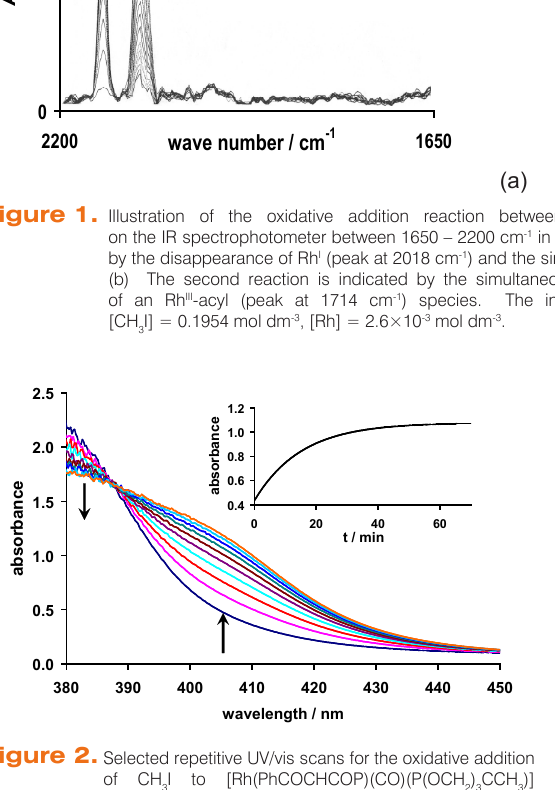
Figure 2. Selected repetitive UV/vis scans for the oxidative addition of CH I to [Rh(PhCOCHCOP)(CO)(P(OCH 3 in chloroform at 25.0(1)°C. Inset Absorbance-time data collected at 410 nm. [CH [Rh] = 2.5×10 -4 mol dm -3 , k